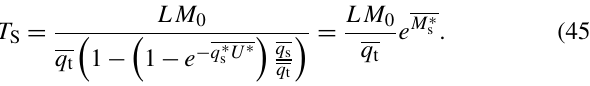
Figure 9. Variation of the exposed bed fraction as a function of transport capacity, assuming that particle speed scales with transport capacity to the power of